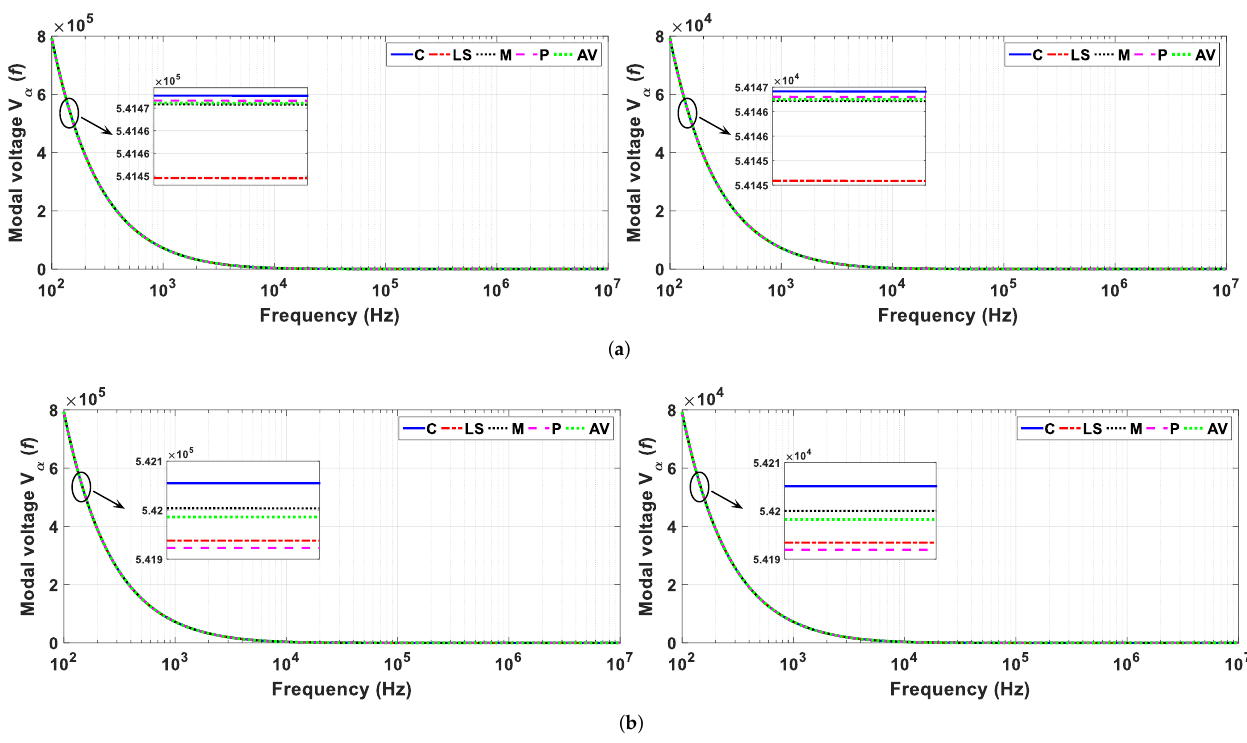
Figure 15. Transient voltages at the receiving end of mode α obtained for the lightning direct strike for the 1 km OHTL ( left ) and 10 km OHTL ( right ) with ρ 0 of: ( a ) 700 Ω · m and ( b ) 4000 Ω · m.